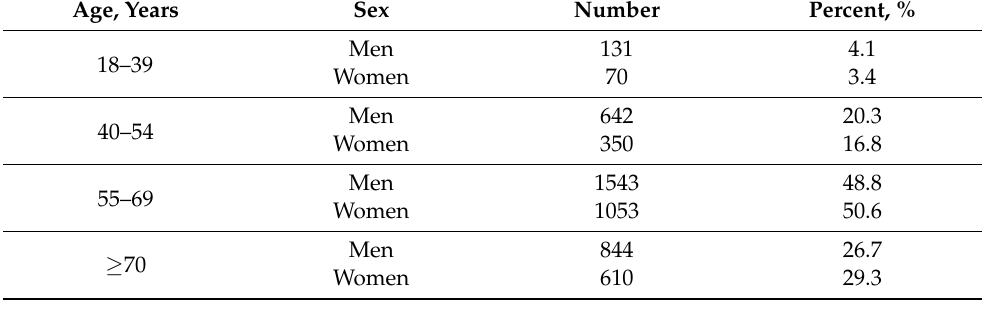
Table 1. Age at diagnostic surgery according to sex for patients with GBM between 1999–2018. Percentages reflect the fraction for each sex separately.